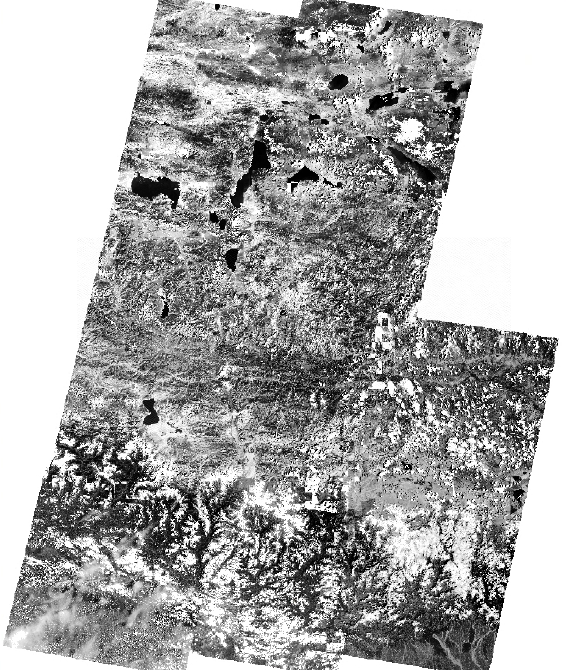
Figure 7. Spark mosaic result.